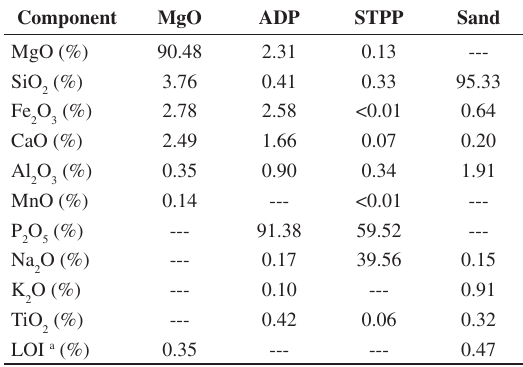
Table 1. Chemical compositions of magnesium oxide (MgO), ammonium dihydrogen monophosphate